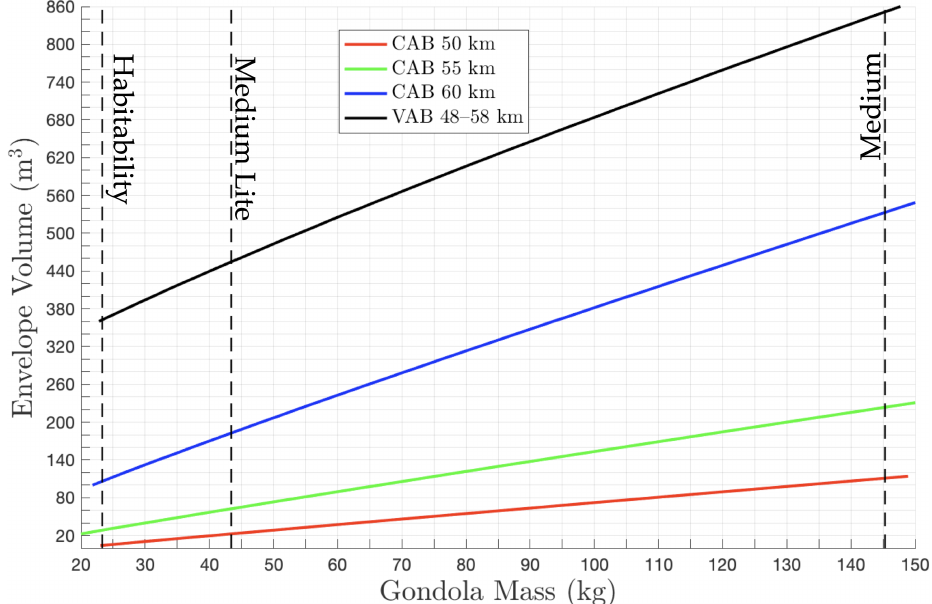
Figure 6. Envelope volume as a function of gondola mass for various Thin Red Line balloons based on calculations provided by Thin Red Line Aerospace Ltd. The x-axis represents gondola mass in kg. The y-axis represents envelope volume in m 3 . On average, for CABs between 50 km and 60 km, the envelope volume more than doubles for every 5 km increase in float altitude. For every kg of mass added to the gondola, the increase in envelope volume is on the order of 1 m 3 . A 48–58 km VAB has an envelope volume at least 240 m 3 greater than the largest CAB accommodating the same